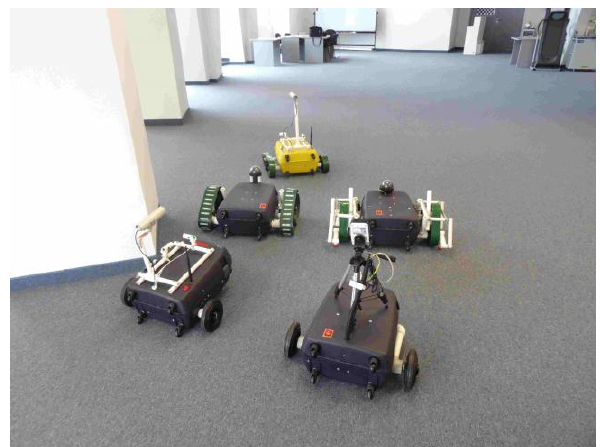
Figure 2. The order of the five mobile robots